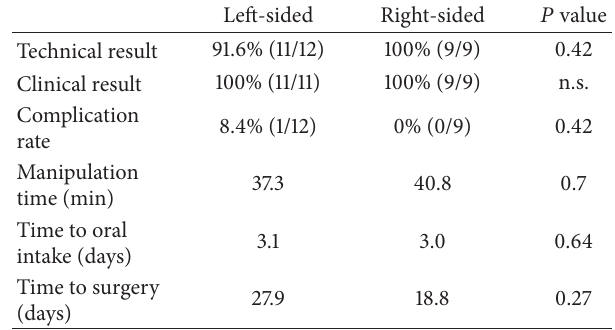
Table 3: Comparison of SEMS insertion between left- and right- sided colonic